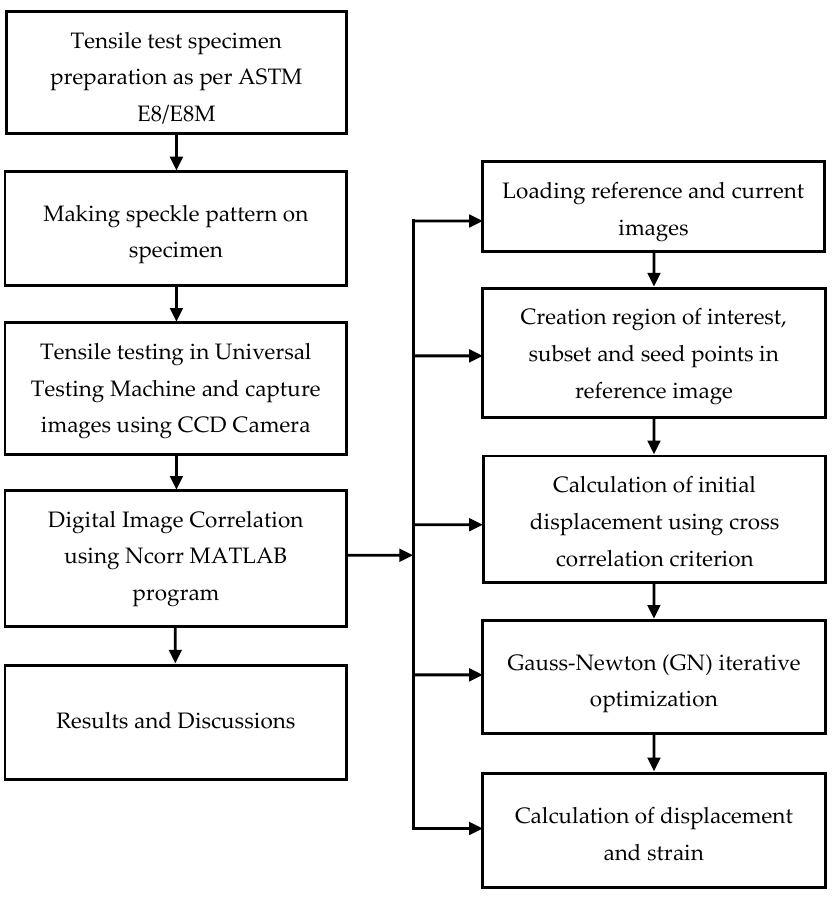
Figure 8. Flow chart for DIC analysis.